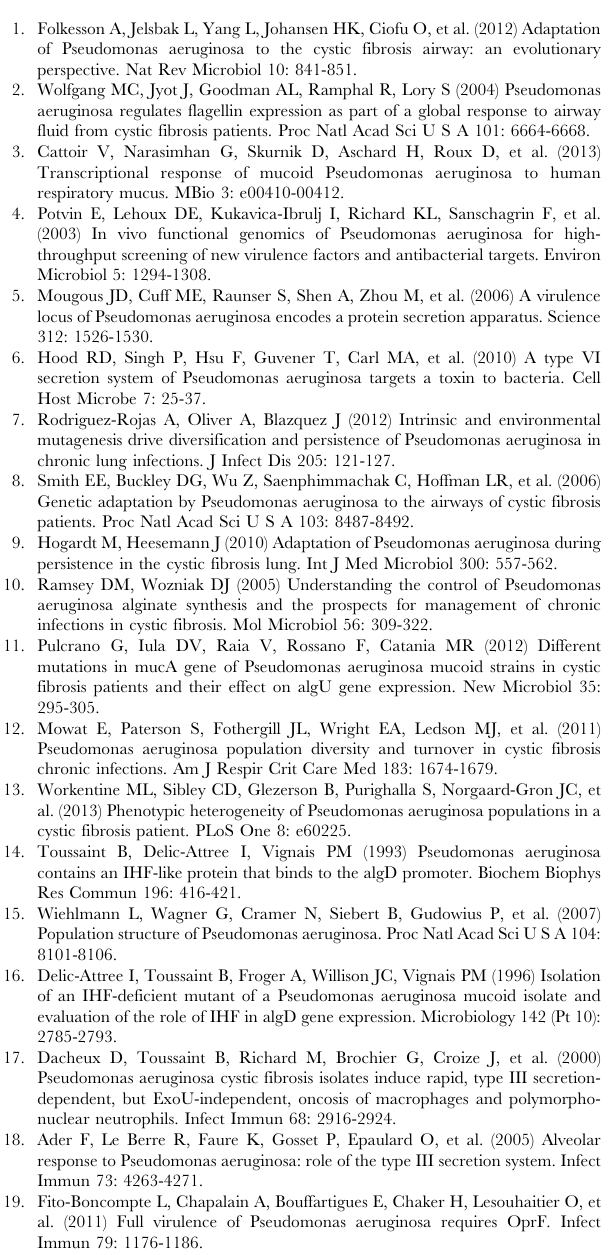
Table S1 Oligonucleotides used in this